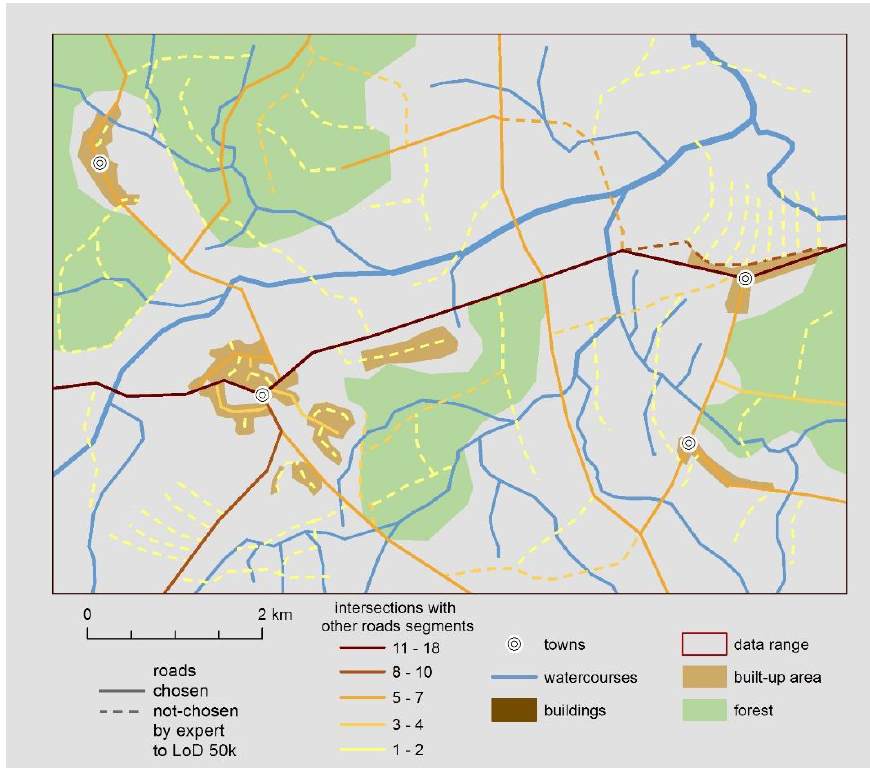
Figure 5. The expert selection of roads 10 k > 50 k (solid lines) juxtaposed with the roads attribute describing the number of intersections with other road segments (geometric atribute), visually showing the importance of the attribute discovered also within reducts.